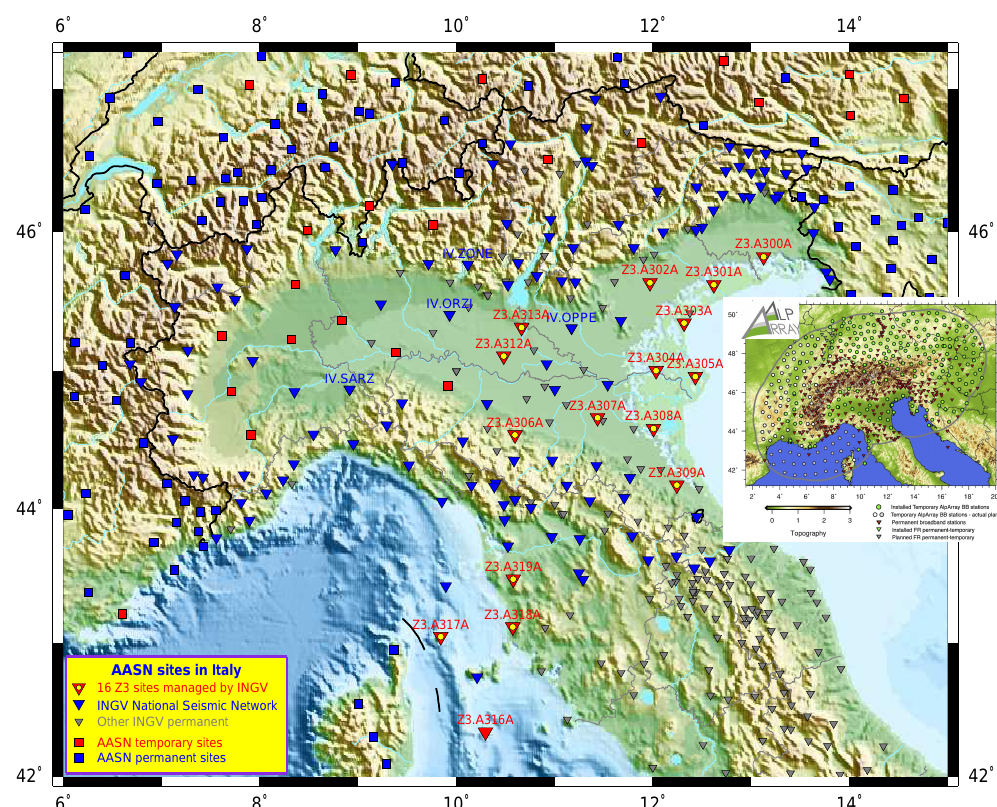
Figure 1. The AlpArray Seismic Network in Italy: the red inverted triangles are the temporary broad-band sites installed and managed by INGV, real-time stations have a yellow dot (all but Z3.A316A) The blue inverted triangles are the permanent Italian sites that belong to the AASN (in gray the other non broad-band permanent sites). The red and the blue squares are respectively the temporary and the permanent sites of the AASN outside Italy. The complete plan of the AASN is in the inset (from the project site). Table 2. Permanent broad-band stations in Italy contributing to the AASN: 115 sites.